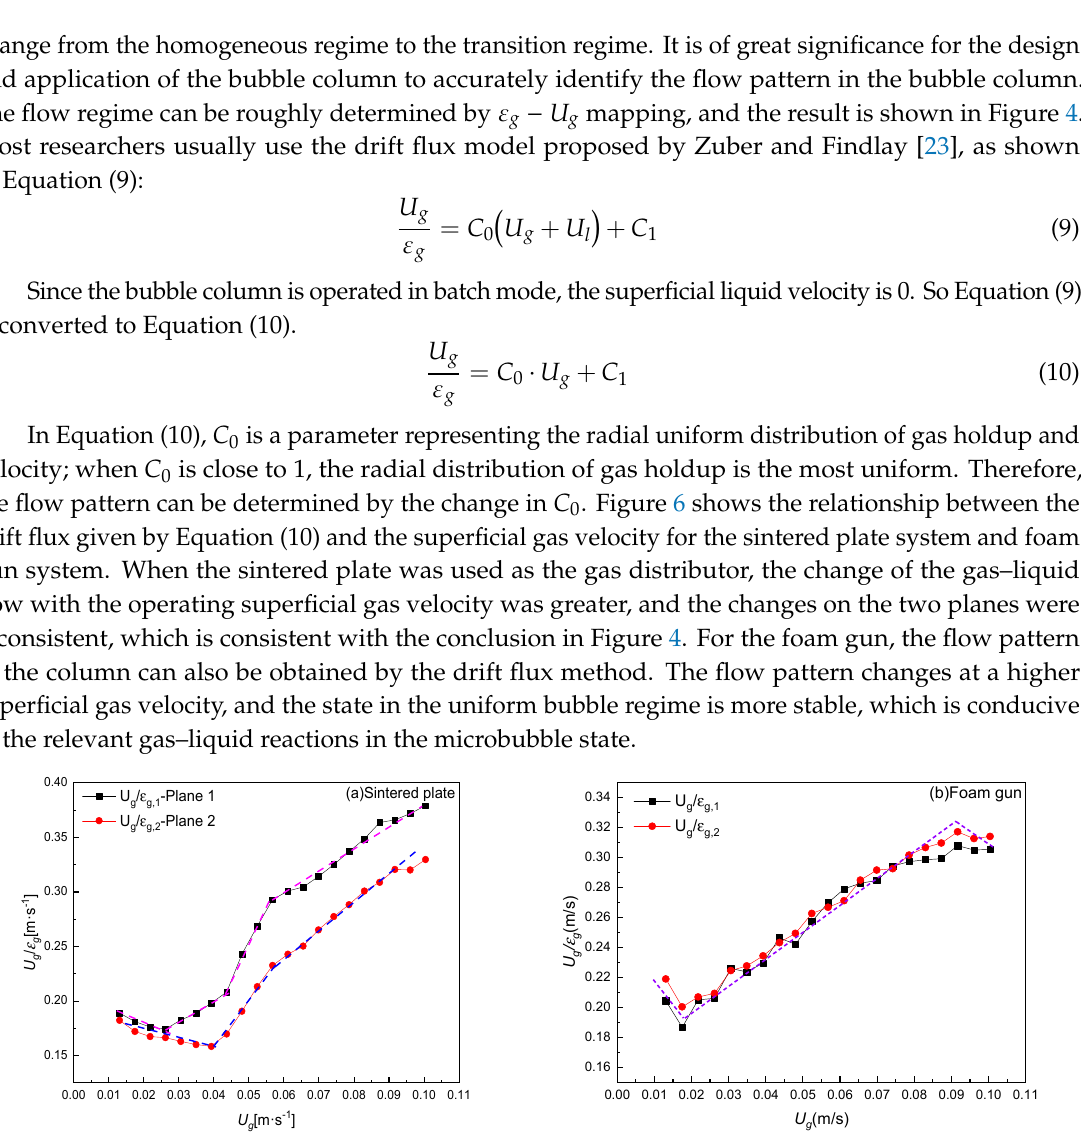
Figure 6. Flow pattern identification with the drift flux method: ( a ) sintered plate and ( b ) foam gun.